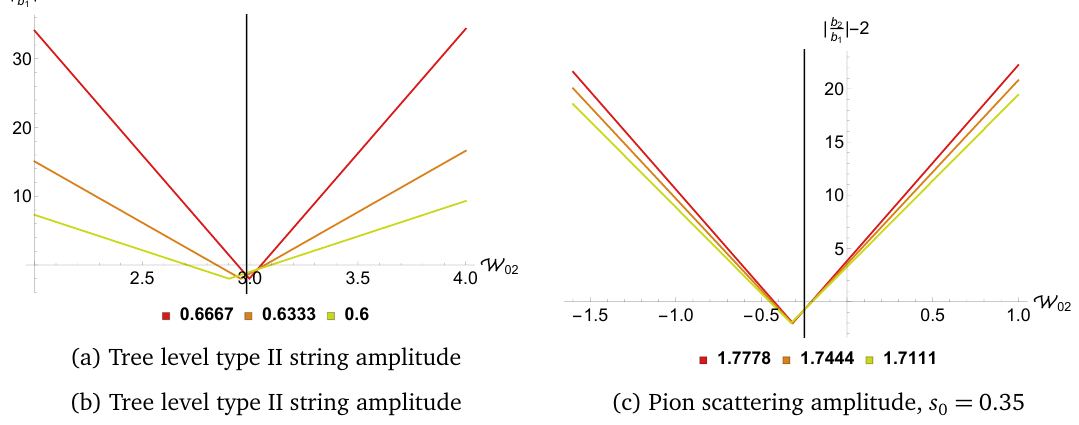
, W , W , W 0,1 1,0 1,1 2,0 0,2